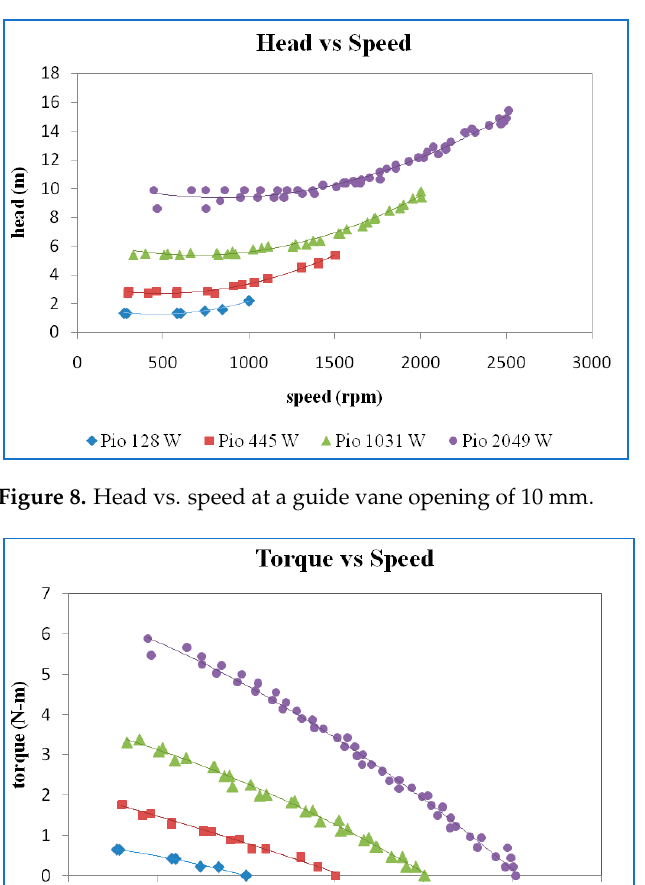
Figure 7. Efficiency vs. speed at a guide vane opening of 10 mm.